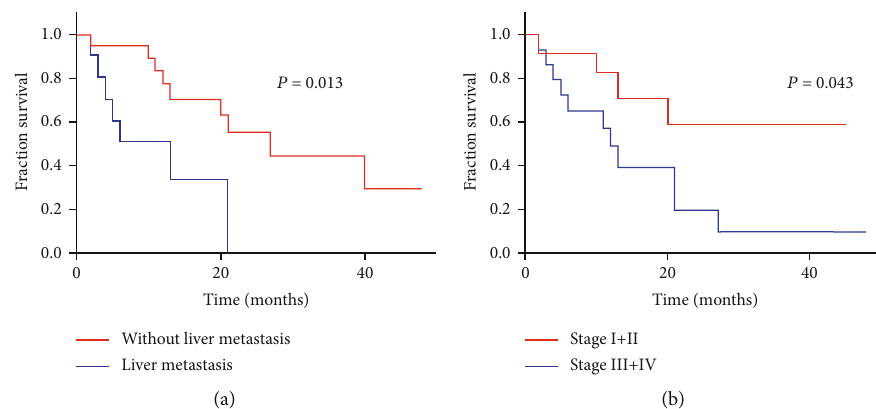
Figure 3: The Kaplan-Meier survival analysis shows the relationship of liver metastasis (a) and tumor stage (b) with overall survival in GB- MiNENs patients. Table 6: The Cox regression and univariate and multivariate analyses of GB-MiNENs.